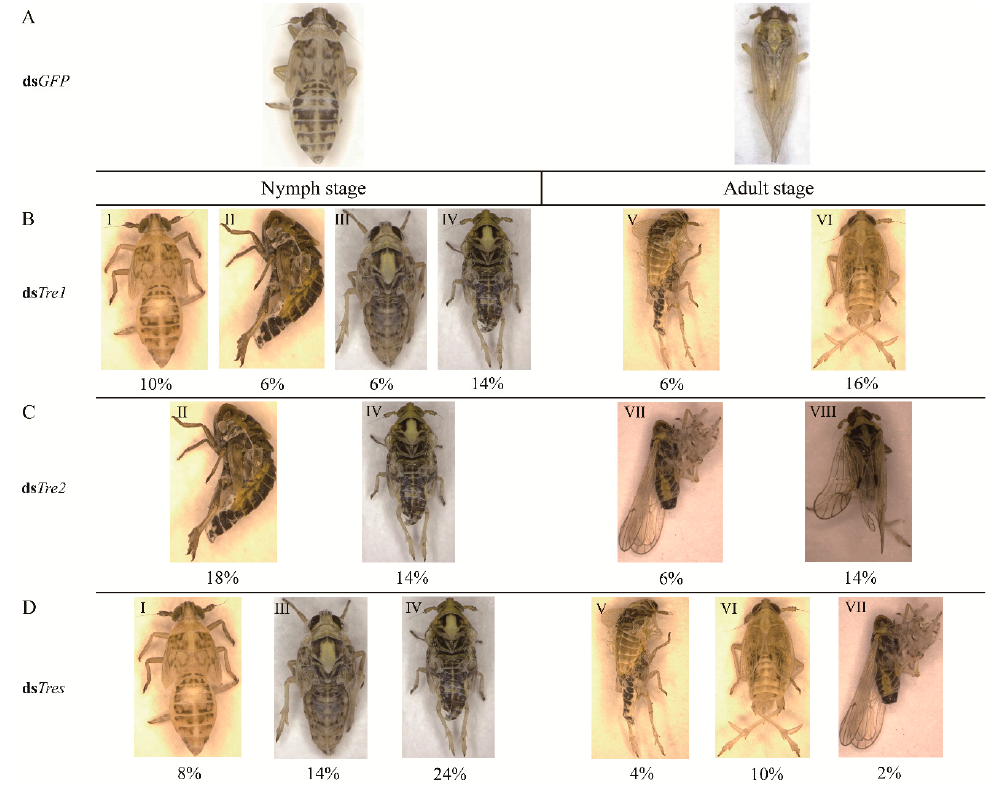
Figure 8. Representative phenotypes of S. furcifera caused by RNAi targeting different dsRNAs. ( A ), ds GFP -injected group; ( B ), ds Tre1 -injected group; ( C ), ds Tre2 -injected group. ( D ), ds Tres -injected group. All abnormal insects in the two stages (nymph and adult stages) were classified into eight types. The percentage below each type of abnormal insect phenotype indicates the corresponding proportion of abnormal insects in the injected group. ds Tres , ds Tre1 + ds Tre2.